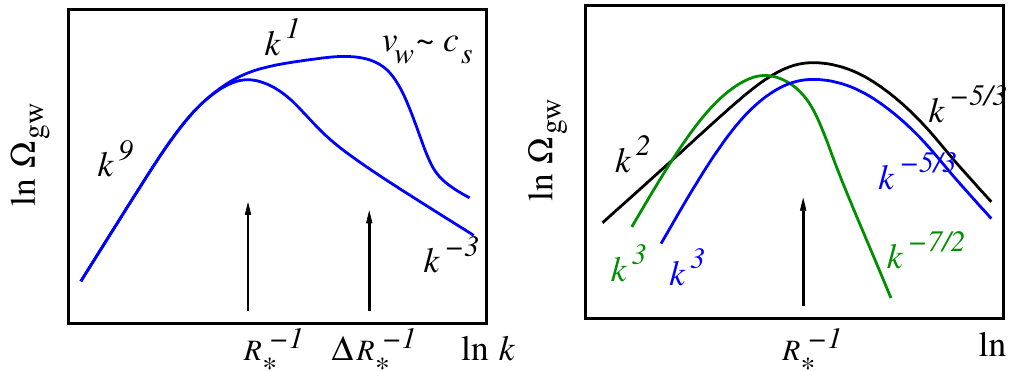
Figure 20: Left panel: shape of the gravitational wave spectrum from sound waves, showing the power laws and the characteristic wavenumber scales, which are deter- mined by the mean bubble centre separation R ∗ and the sound shell thickness ∆ R ∗ . Right panel: survey of predictions of the power spectrum from modelling of turbulent gravitational wave production, from [ 105 ] (green), [ 102 ] (“top-hat” autocorrelation, black), and [ 106 ]